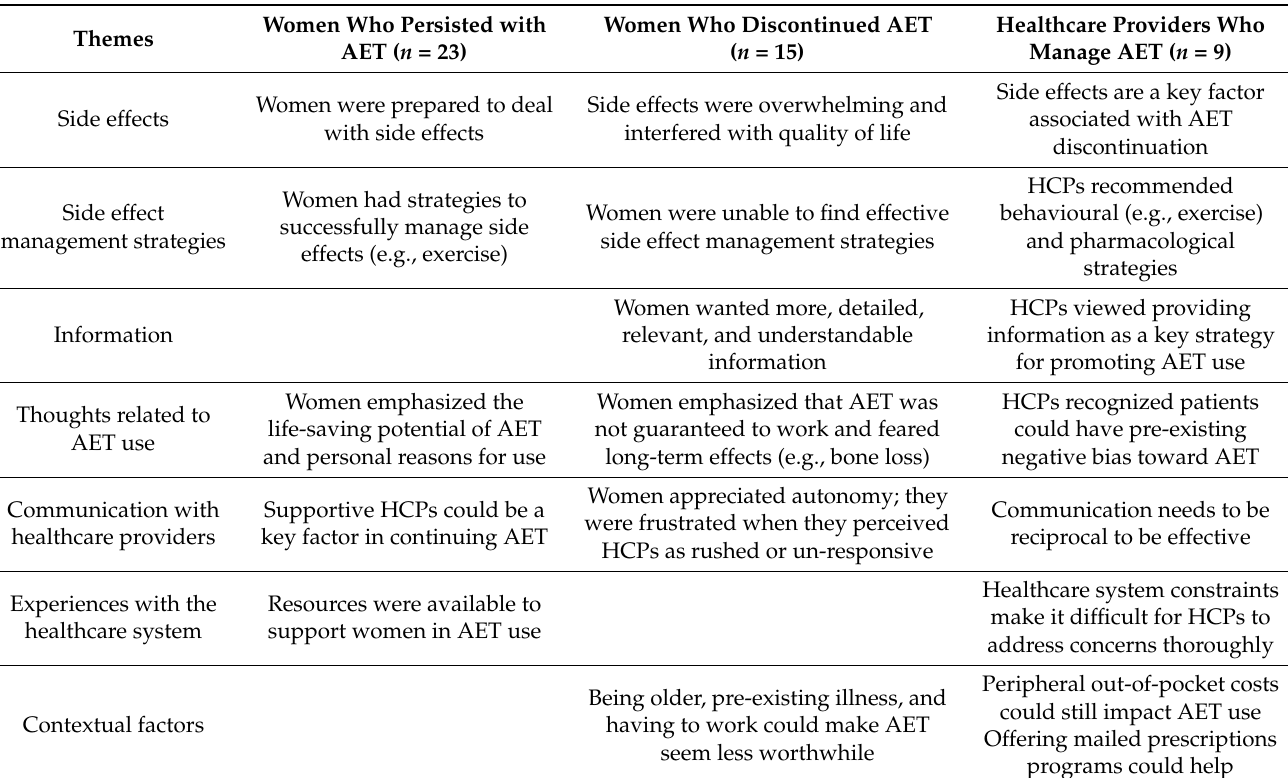
Table 5. Comparison of themes across